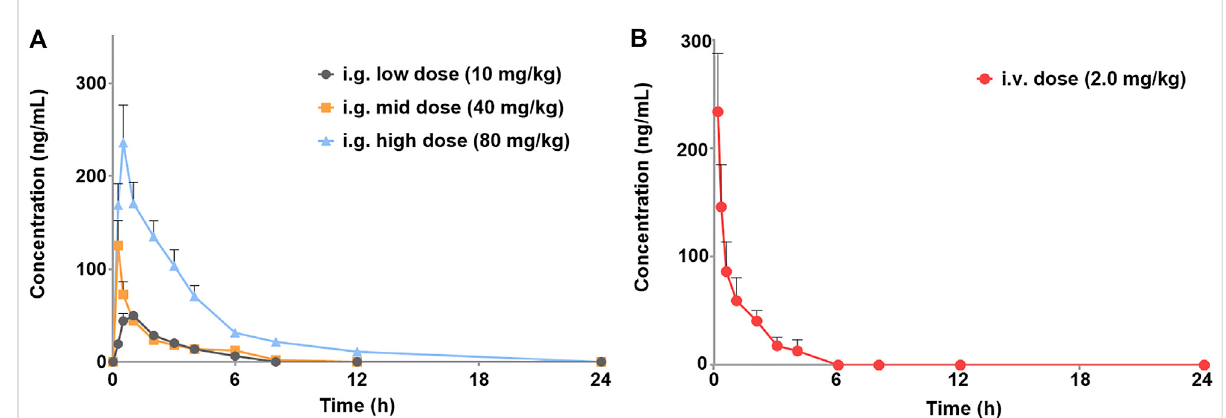
FIGURE 4 Plasma concentration-time pro fi les of curcumol are given (A) i.g. Doses of 10, 40, 80 mg/kg of curcumol ( n = 5, mean ± SEM) and given (B) i.v. Dose of 2.0 mg/kg of curcumol ( n = 5, mean ± SEM).